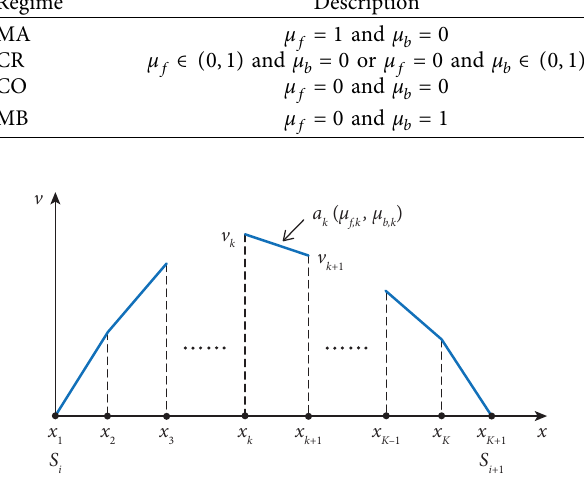
Figure 1: Te illustration of the section